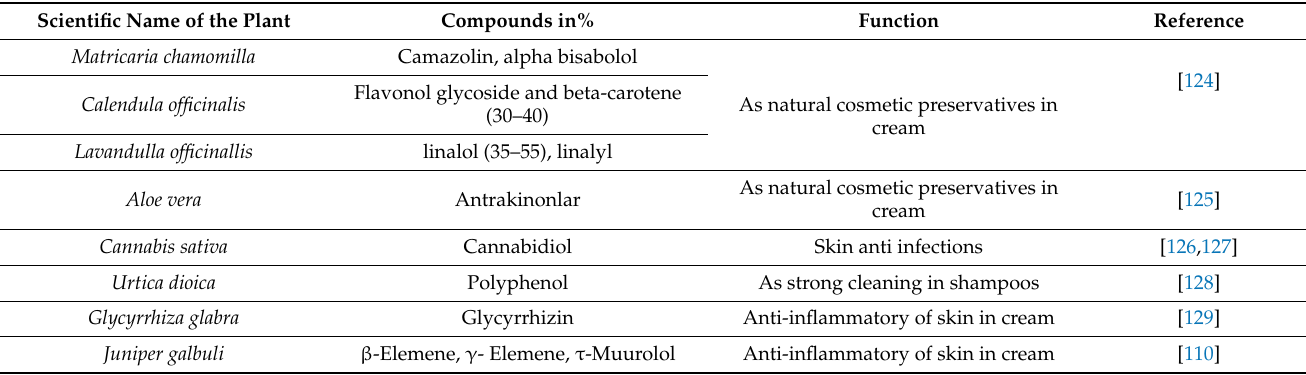
Table 5. Some medicinal plants used in the cosmetic